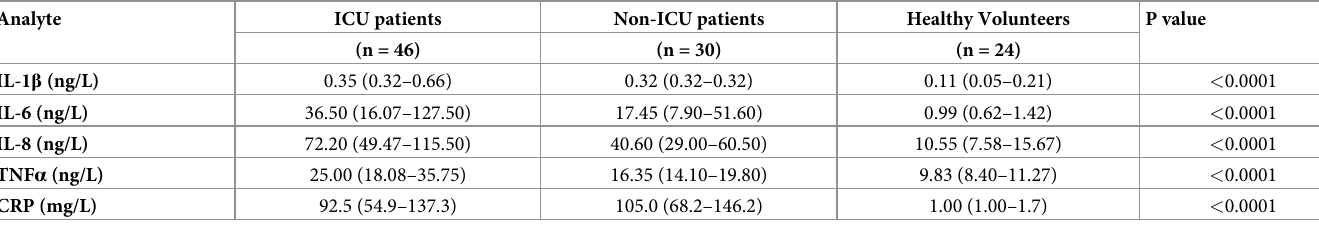
Table 1. Cytokine panel and CRP between ICU, non-ICU patients and healthy volunteers. Analyte